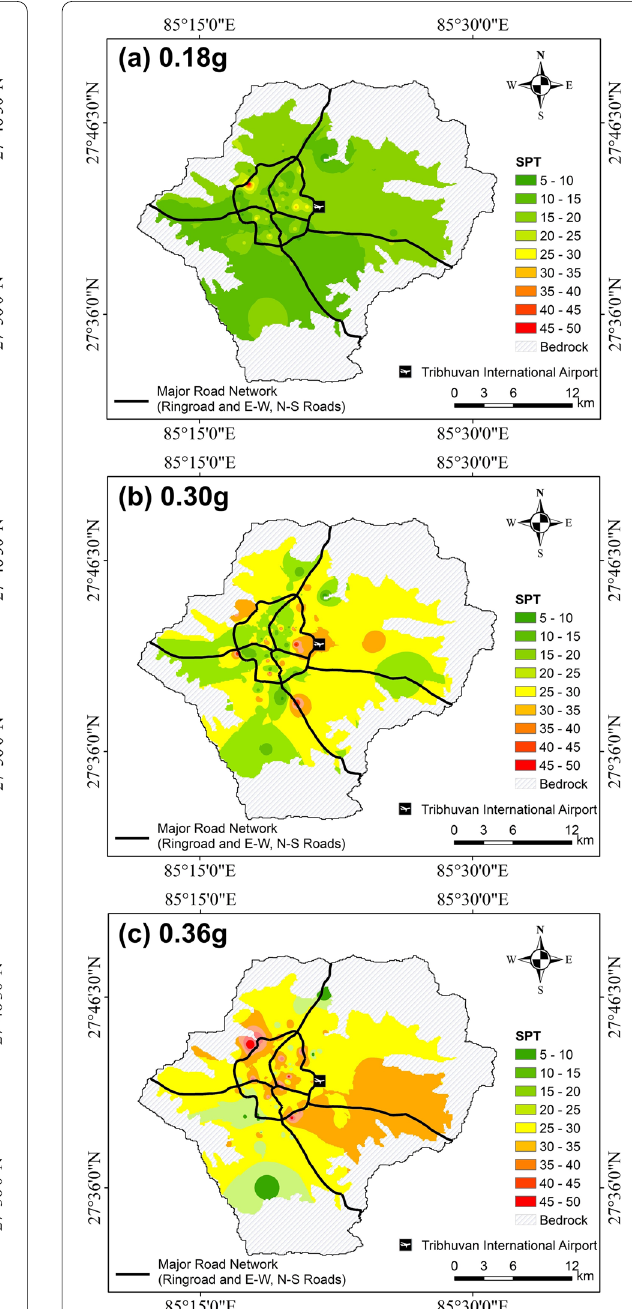
Fig. 16 Improved SPT-N ( N improved ) distribution map of the Kathmandu Valley for FOS of 1.5 for the seismic scenarios of a 0.18